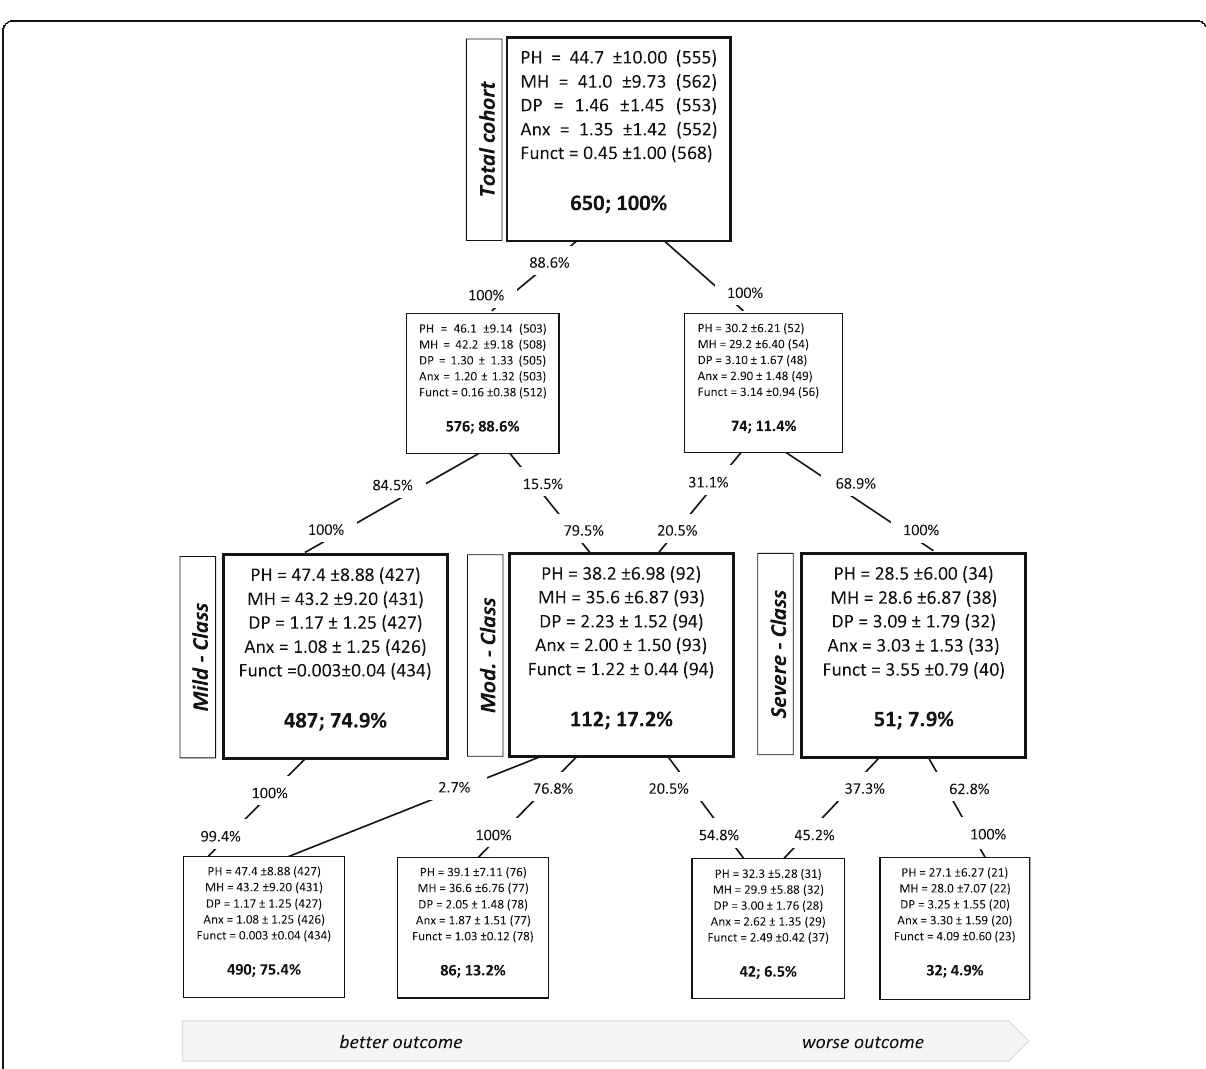
Fig. 1 Class Evolution Tree of the four empirically most strongly supported models from the latent profile analysis. The bold numbers indicate absolute and relative frequency. The depicted variables are patient-reported outcomes. Abbreviations: PH = physical health; MH = mental health; Dep = depressive symptoms; Anx = anxiety; Funct = functional status; mod. =